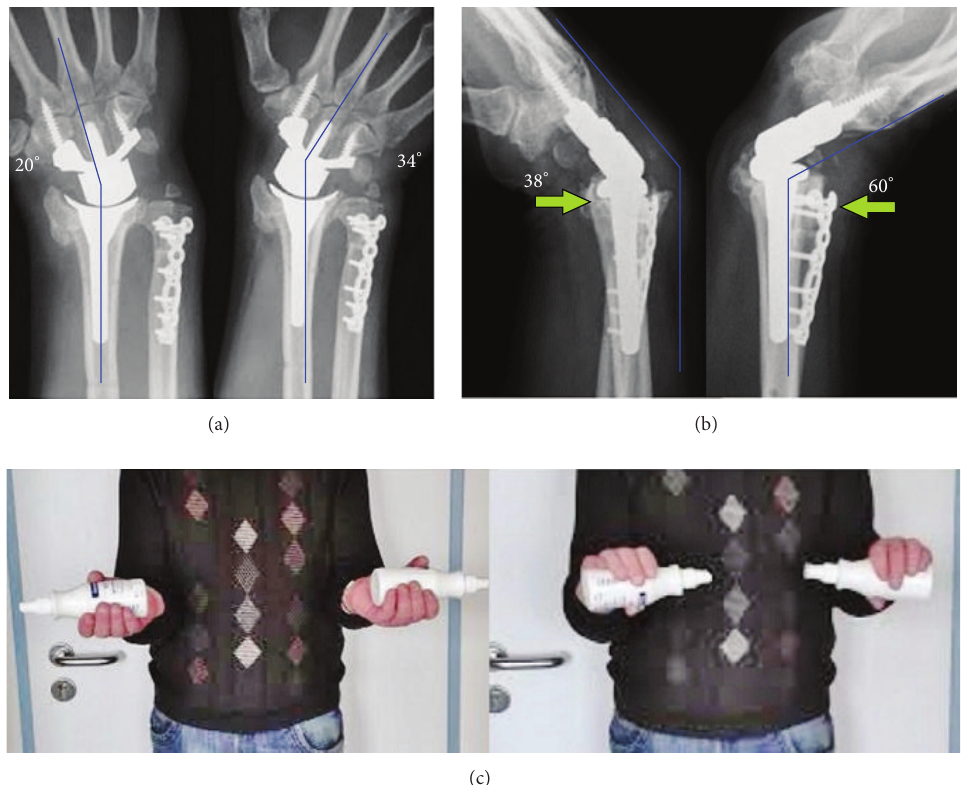
Figure 3: Case report 1 (1-year follow-up): (a) AP radiographs with terminal range of motion: no signs of loosening of either implant and no impingement or impaction; note the union of USO; (b) lateral radiographs with terminal range of motion: no subluxation of distal ulna ( arrows ); (c) clinical photo with supination-pronation arc on both